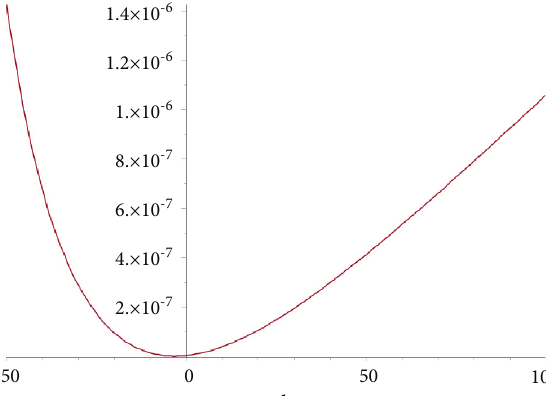
� G ( c ) when − 50 ≤ c 2 2 1